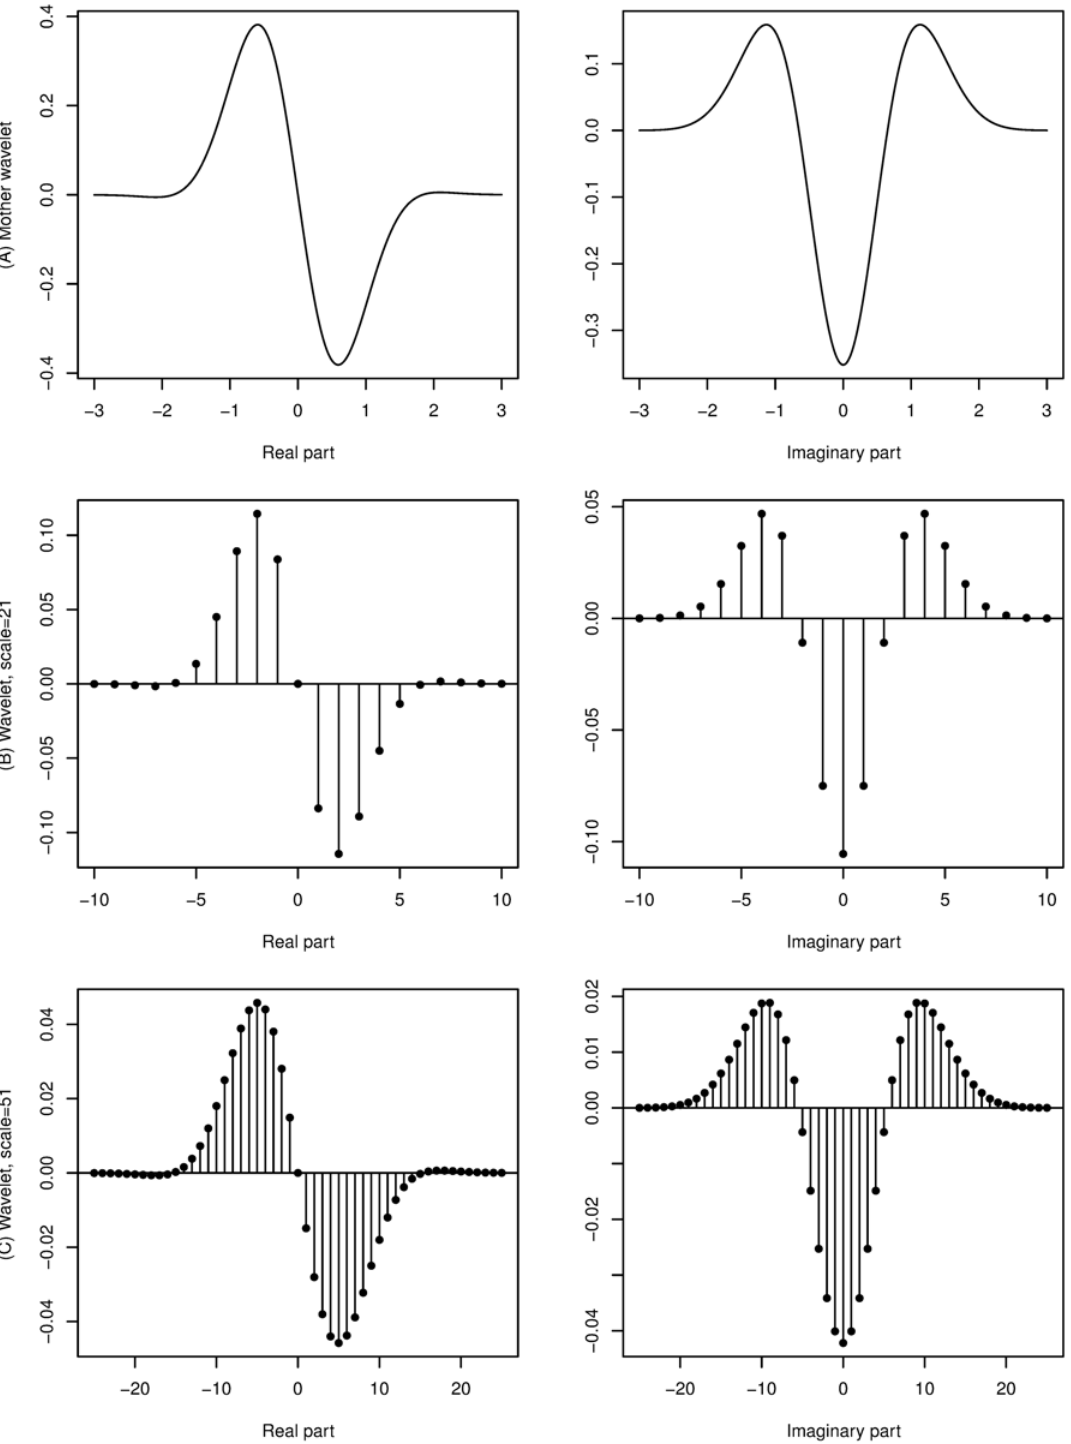
Fig 1. Example of a mother wavelet function. From top: (A) complex Gaussian derivative mother wavelet f ( t ) = ( − 2 x − i )exp( − x 2 − ix ), (B) example wavelet of scale s = 21, (C) example wavelet of scale s =